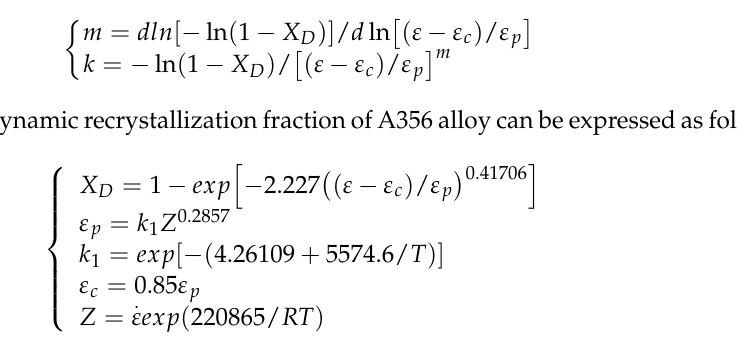
. ε = 0.01, ε = 0.6; (N4) T = 400 ◦ C, . ε = 1, ε =